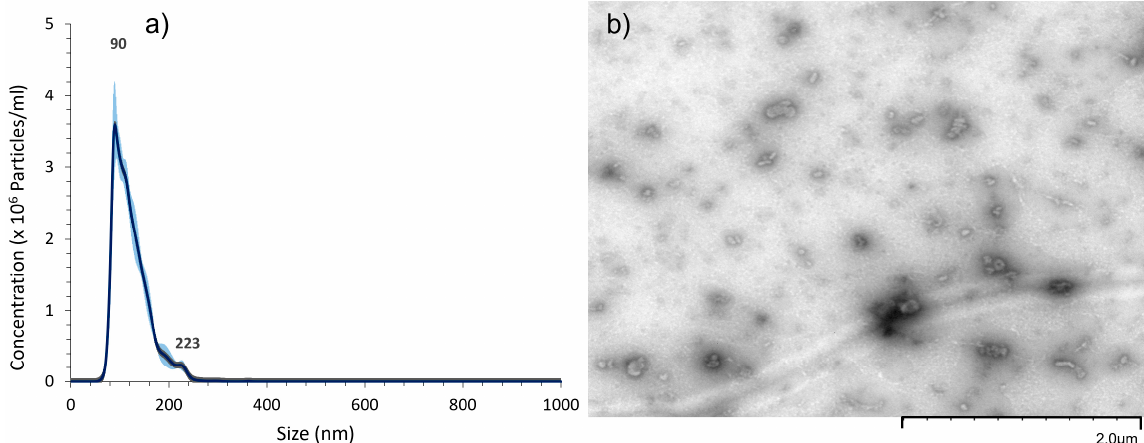
Figure 3. ( a ) Nanoparticle tracking analysis (NTA) and ( b ) transmission electron micrograph (TEM) of extracellular vesicles obtained from mouse macrophage J774 cultures.